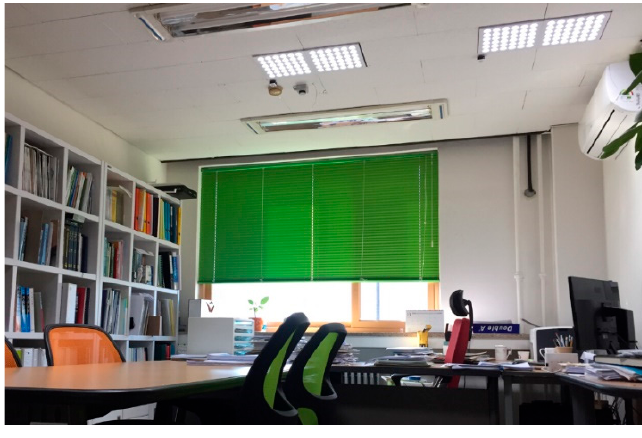
Figure 1. Inside view of the target space. Table 2. General information on the target space and energy consuming devices.